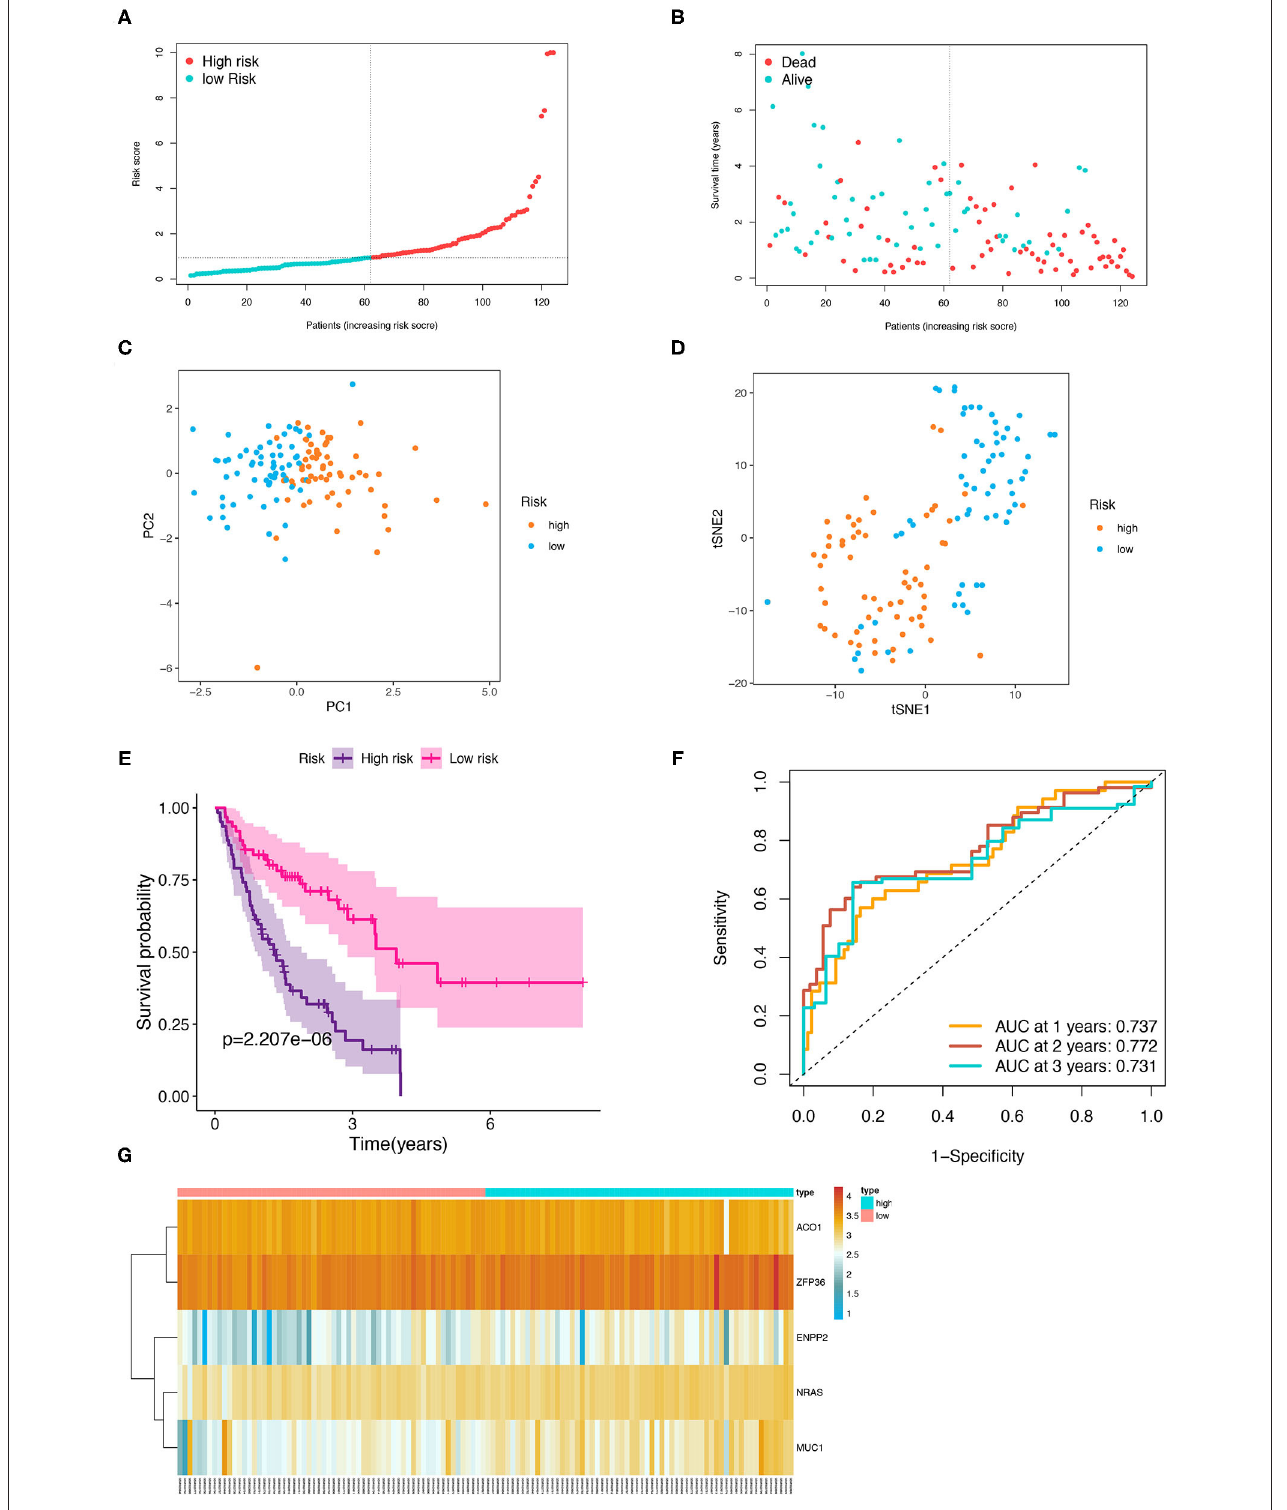
FIGURE 5 | Prognostic analysis of the five-FRGs signature in the training group. Distribution of IPF samples (A) and OS status (B) based on the median risk score. PCA (C) and t-SNE (D) analysis of the training group. Kaplan–Meier survival (E) and time-dependent ROC curve (F) analysis of the five-FRGs signature in training group. (G) Heatmap of the expression profiles of the five-FRGs in low- and high-risk groups. FRGs, ferroptosis-related genes; IPF, idiopathic pulmonary fibrosis; OS, overall survival; PCA, principal component analysis; t-SNE, t-distributed stochastic neighbor embedding; ROC, receiver operating characteristic.